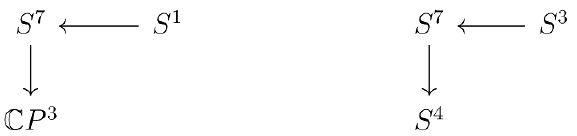
Figure 1 . Hopf (cid:12)brations of S 7